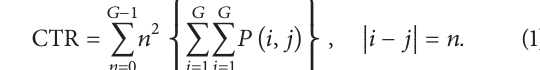
Figure 2: Offset